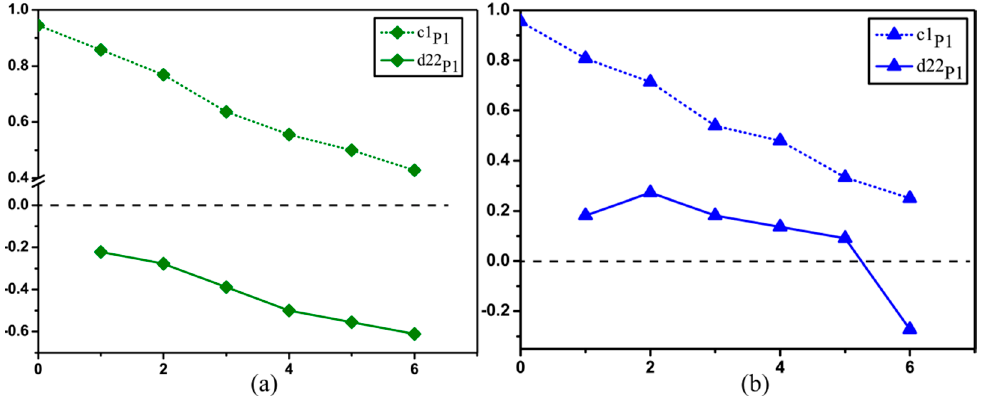
Figure 8. Monte Carlo simulation results of the parameters c 1 p1 and d 22 p1 using the SCSM. ( a ) The x -axis represents different values of sphere/cylinder ratio from (1) 10:70 to (2) 13:67; (3) 15:65; (4) 21:59; (5) 22:58; (6) 27:53 and (7) 28:52; ( b ) The x -axis represents different values of the diameter and standard deviation of angular distribution of the cylinders from (1) 1.5 µm 15 degree to (2) 1 µm 15 degree; (3) 0.9 µm 19 degree; (4) 0.86 µm 19 degree; (5) 0.76 µm 20 degree; (6) 0.68 µm 21 degree; and (7) 0.68 µm, 22 degree.